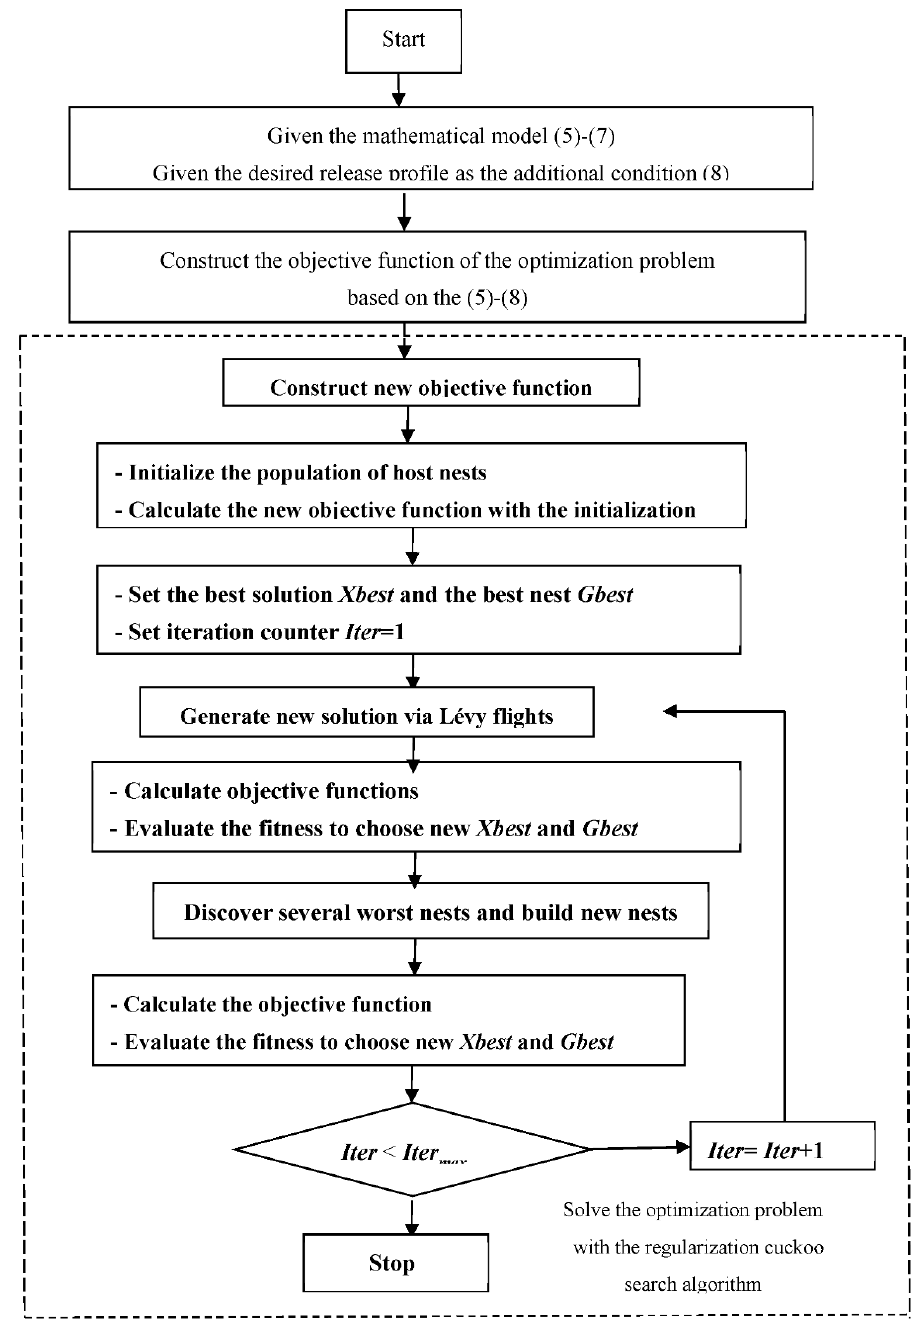
Figure 2. Theoutlineoftheinverseproblemsolutionschemewiththeregularizationcuckoosearch Figure 2. The outline of the inverse problem solution scheme with the regularization cuckoo search algorithm .